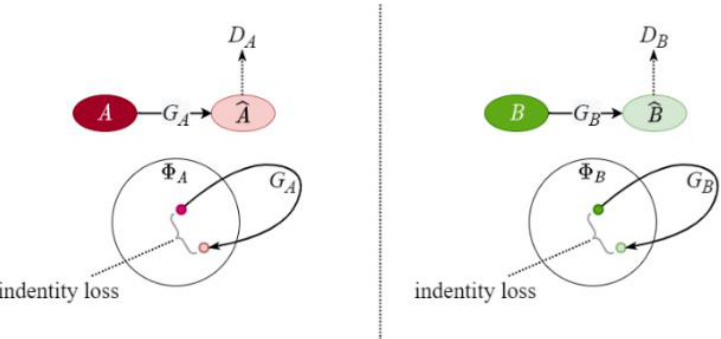
Figure 4. Identity mapping.